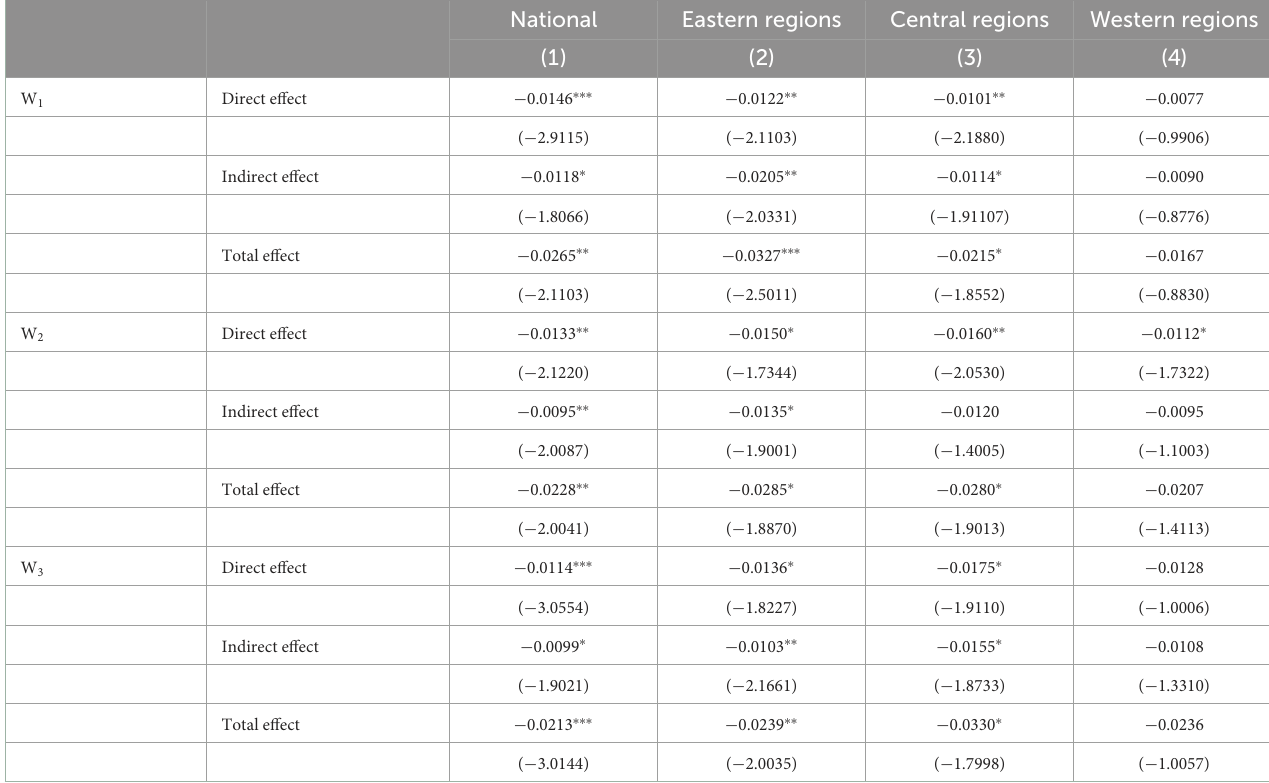
TABLE 6 Spatial spillover effects and regional differences.